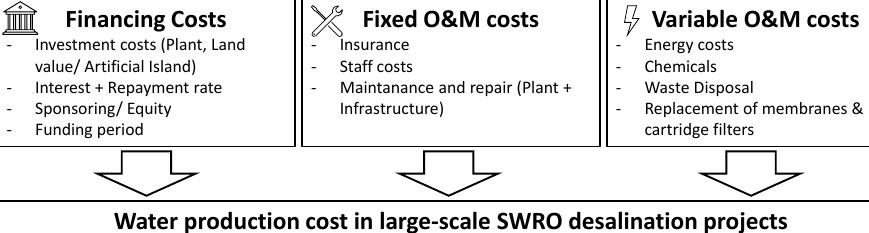
Figure 5. The main influences on the water production cost.